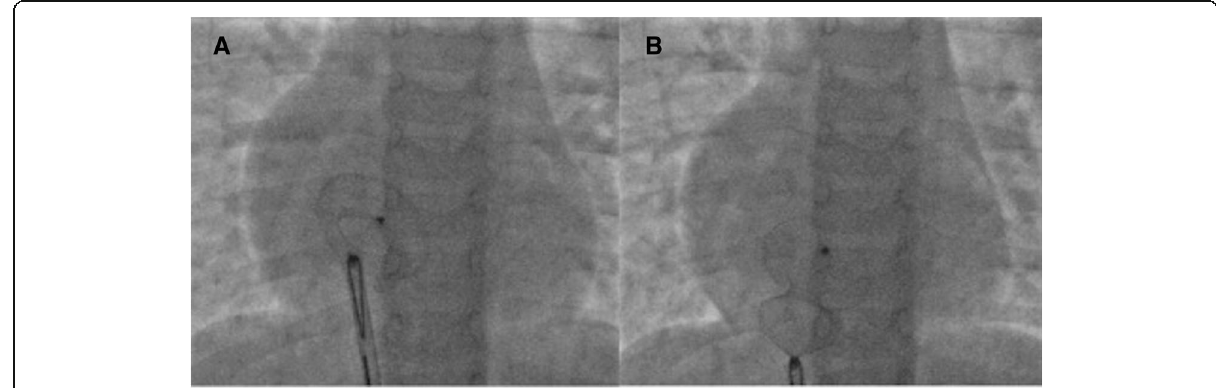
Fig. 6 Manipulation of the device with a snare passed over the delivery sheath. The nicks in the delivery sheath could have helped in securing alignment across the septal defect ( A ). Controlled Minnesota manoeuvre with the snare ( B )